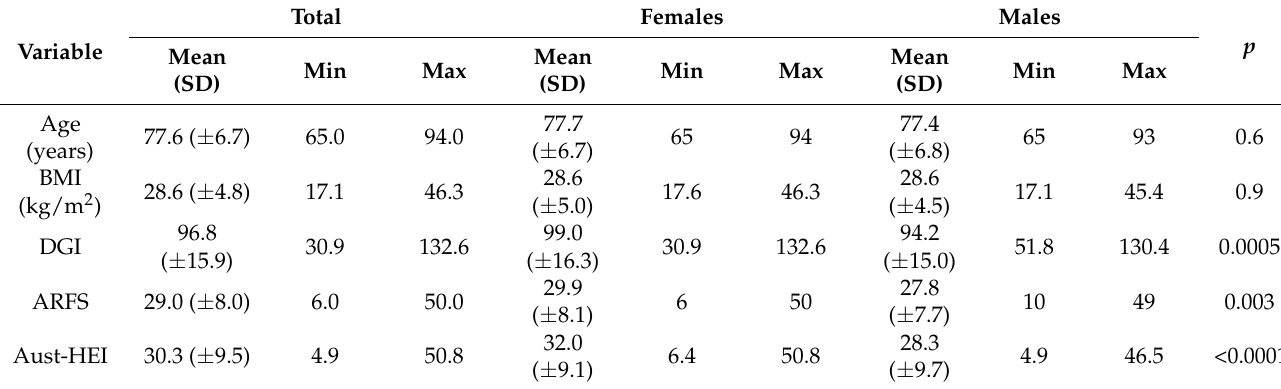
Table 1. Distribution of continuous variables by total cohort and by sex.